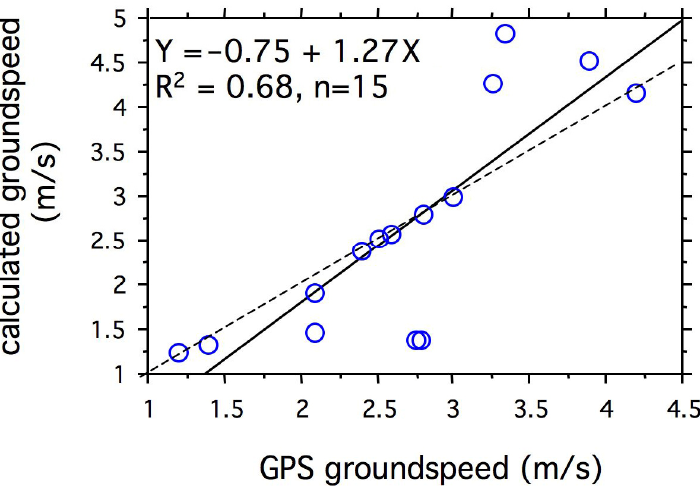
Figure 3. Groundspeed calculated from the vector analysis of airspeed, track over ground, wind speed, and wind direction relative to groundspeed measured with a Garmin marine differential GPS. The solid line shows the regression of the calculated values on those measured, and the dashed line indicates a one-to-one correspondence.